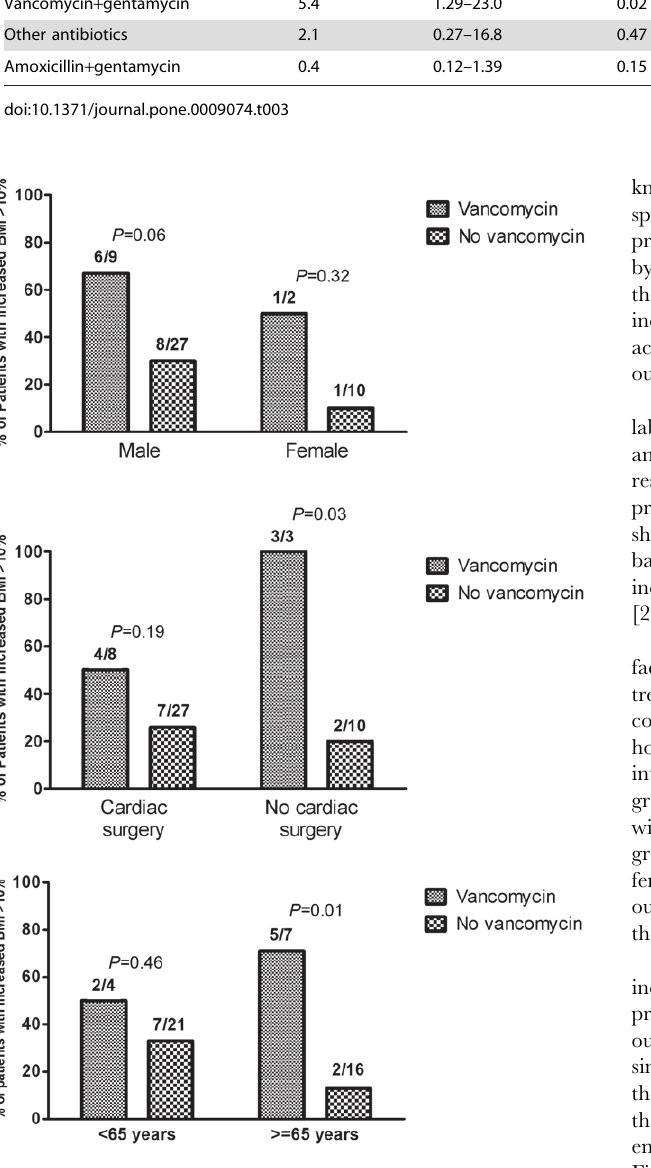
Figure 3. Impact of vancomycin treatment on the risk of major increase of body mass index (BMI $ 10%) inpatients treated for in- fectiveendocarditisaccordingtoage,gender,andcardiacsurgery. doi:10.1371/journal.pone.0009074.g003 PLoS ONE |